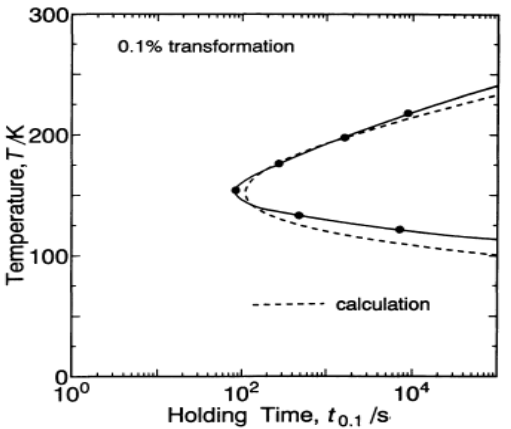
Figure 3. Time ‐ temperature ‐ transformation (TTT) diagram of the isothermal martensitic Figure 3. Time-temperature-transformation (TTT) diagram of the isothermal martensitic transformation transformation in Fe ‐ Ni ‐ Mn alloy. Thick lines with closed circles represent measured values and in Fe-Ni-Mn alloy. Thick lines with closed circles represent measured values and dotted lines represent dotted lines represent calculated values [45], with copyright permission from © JIM . calculated values [45], with copyright permission from ©